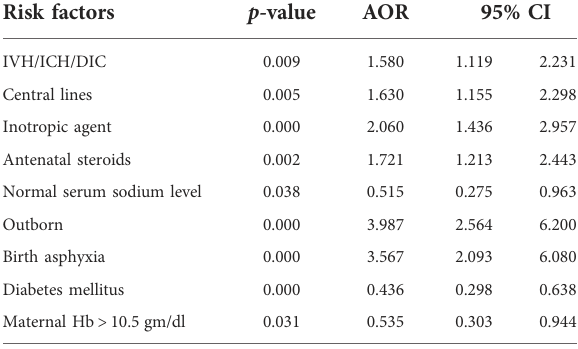
TABLE 2 Multinominal logistic regression for risk factors of AKI.